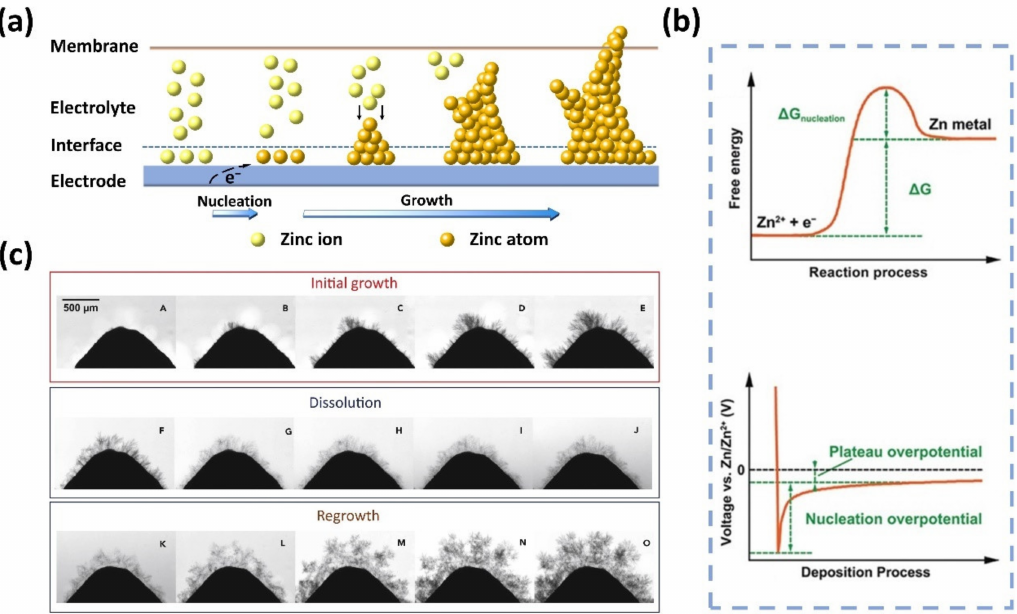
Figure 1. ( a ) Schematic illustration of the formation and growth of Zn dendrites. ( b ) The energy barrier involved in Zn nucleation and the typical voltage profile during Zn deposition. (Reproduced from [69] with permission from Wiley.) ( c ) The growth, dissolution, and regrowth process of Zn dendrites during battery cycling. (Reproduced from [80] with permission from